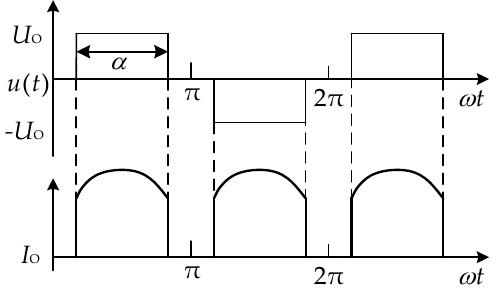
Figure 5. Waveforms of the input voltage and output current of one active rectifier.